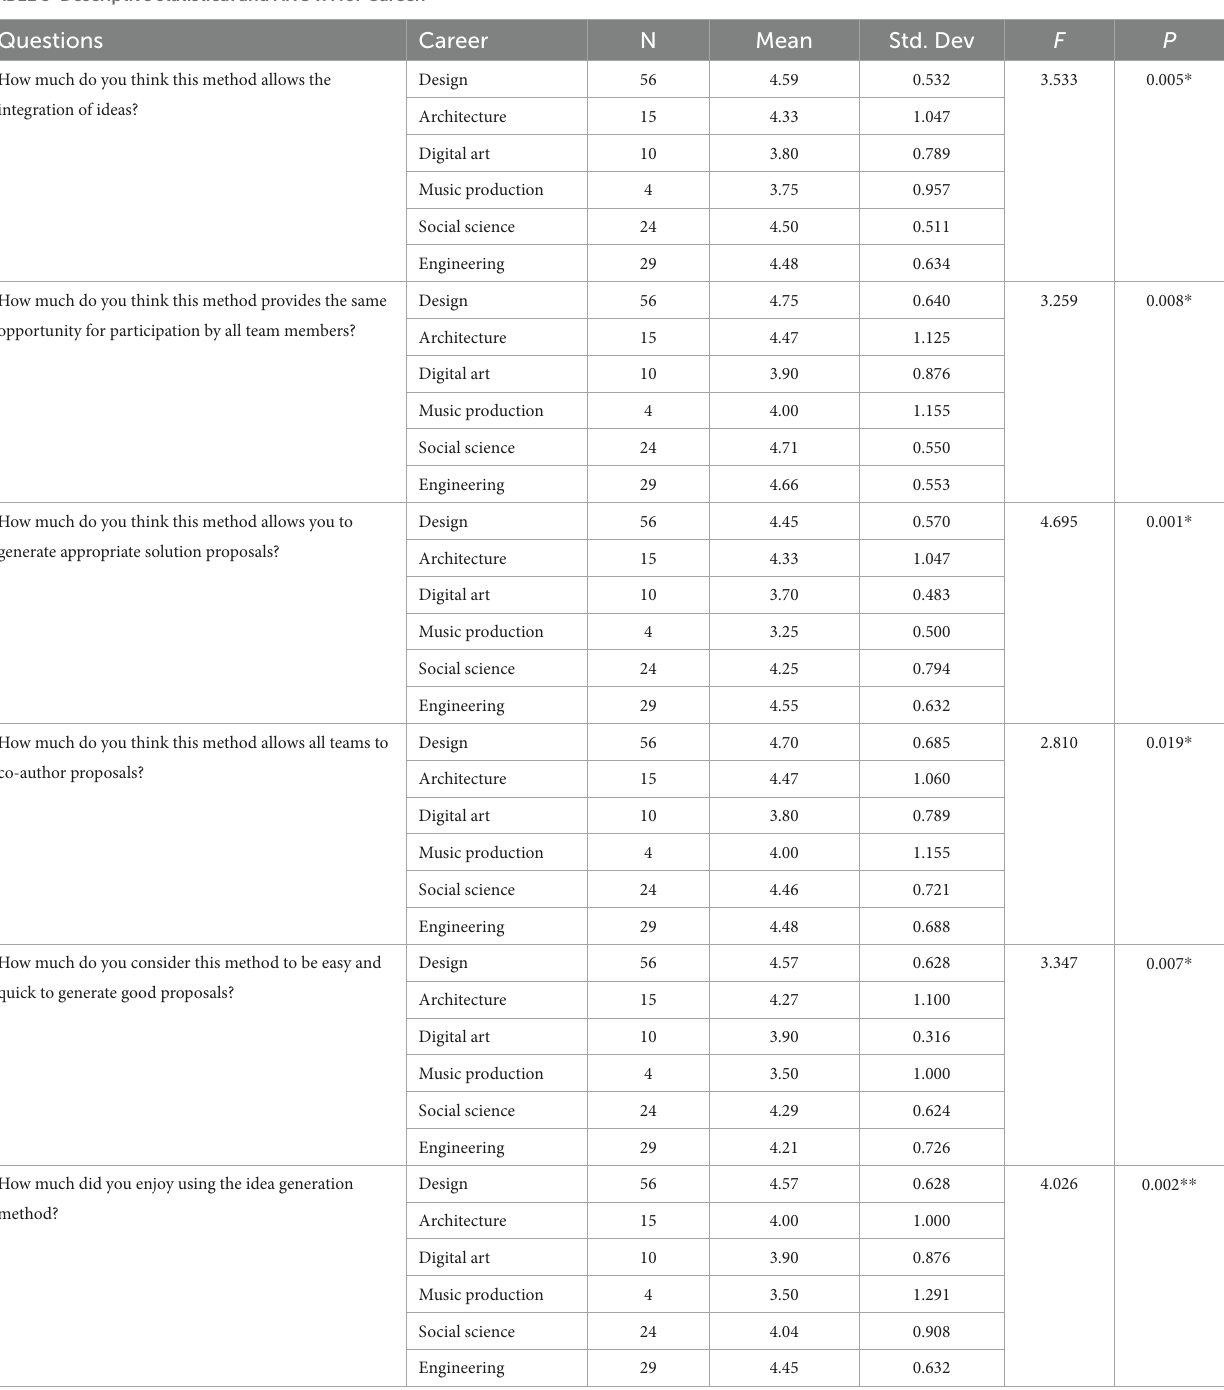
TABLE 3 Descriptive statistical and ANOVA for